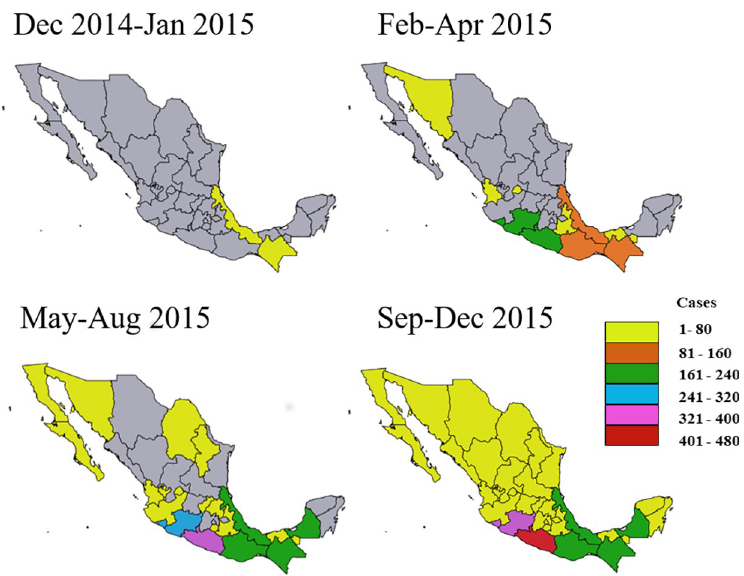
Fig 1. Accumulation of confirmed CHIKV cases per state over time. Political maps of Mexico with state borders shown. Confirmed cases through molecular diagnosis were from patients who attended any of the 35 IMSS clinical centres nationwide. Grey indicates that no cases were